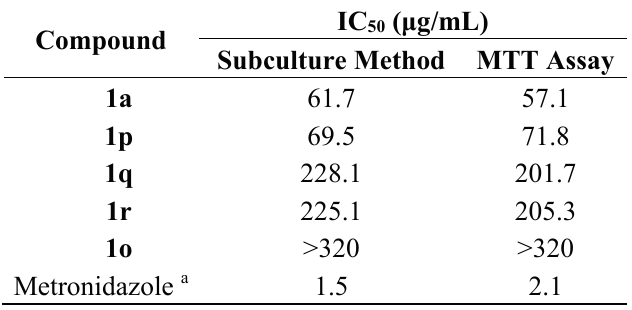
Table 3. Half maximal inhibitory concentration of chromone-tetrazoles against E. histolytica by Subculture method and MTT